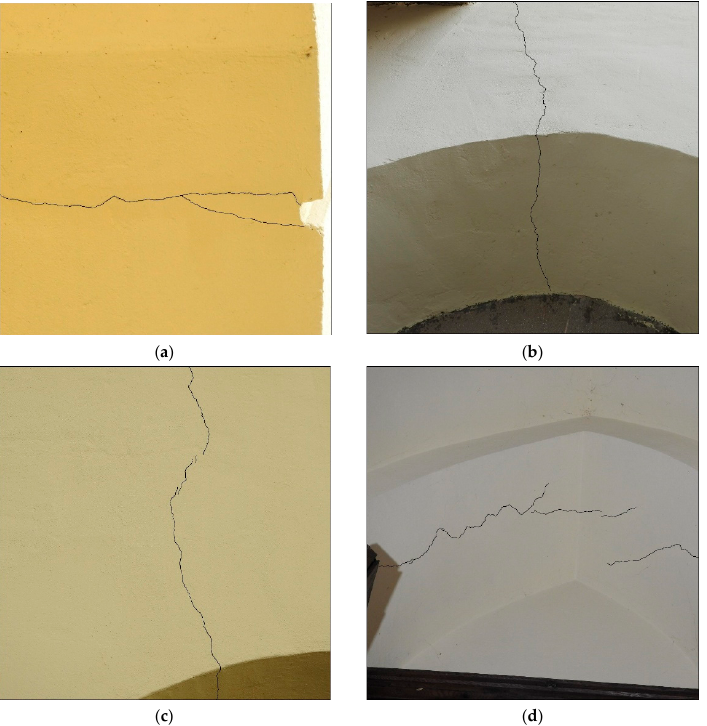
Figure 12. Examples of damage on arches and vaults marked on map of cracks: ( a ) Crack on arch over entrance (ID 2 in Figure 10a); ( b ) Crack on lintel arch (ID 4 in Figure 10a); ( c ) Crack stretching across arch and façade wall above it (ID 14 in Figure 10a); ( d ) Cracking of pointed arch over window (ID 21 in Figure 10b).